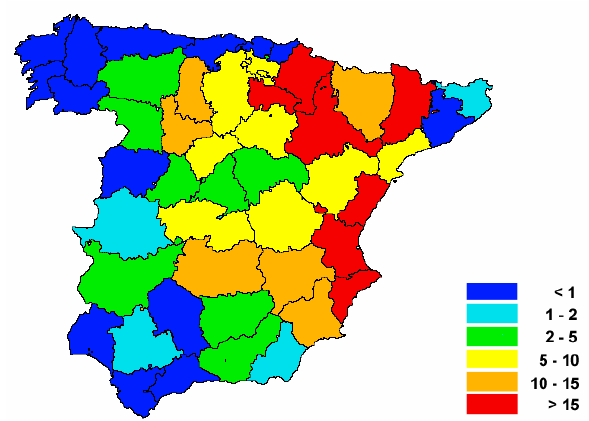
Fig. 1. Average hail claims per ha in 2005–2007 period for the provinces of Peninsular